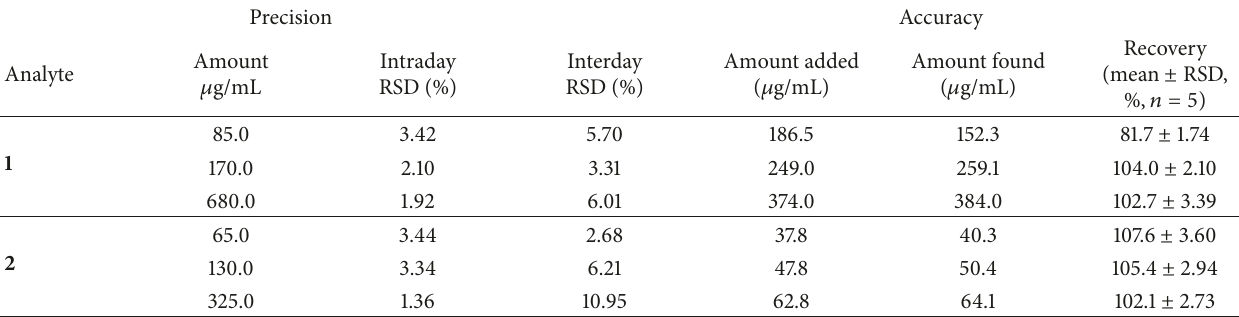
Table 2: Precision and accuracy for 1 and 2 in Plectranthus samples.